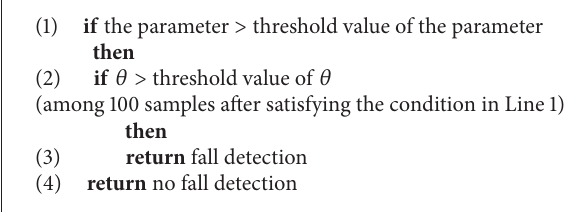
Figure 3: Configuration of fall-detection system applying HMM.